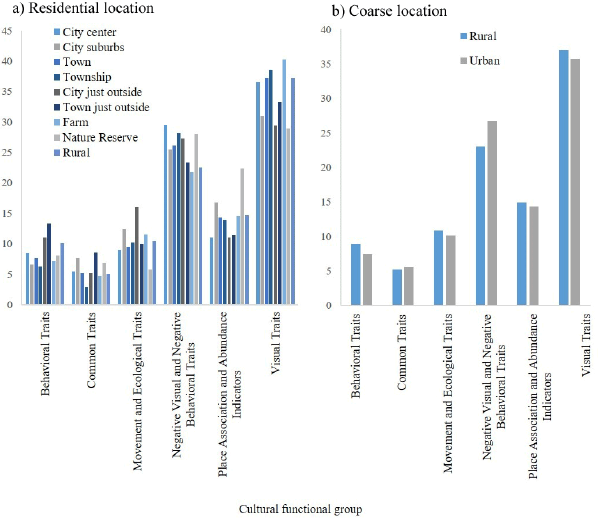
Fig. 3 . Percentage distribution of socio-demographic characteristics between dimensions of cultural functional groups: (a) residential location and (b) coarse